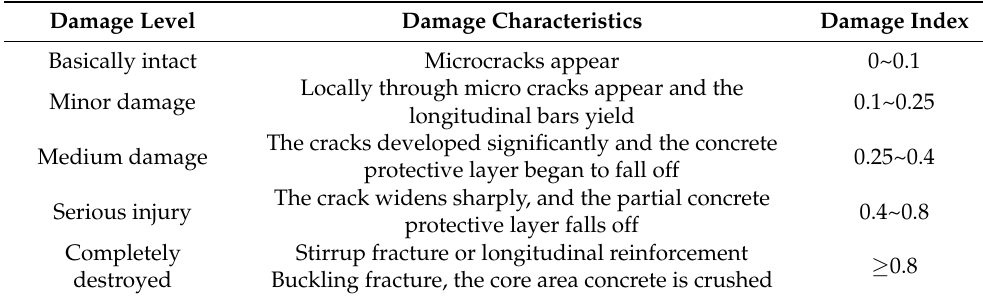
Table 1. Range of damage index for different damage